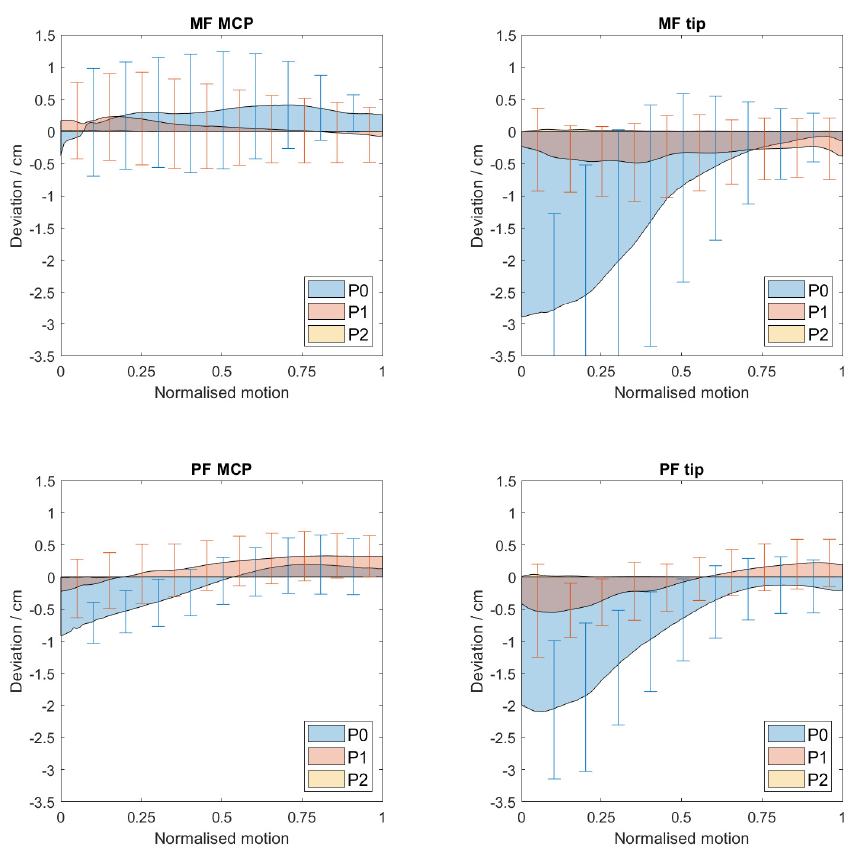
Figure 9. Deviation of the finger joints’ trajectories from their base-line